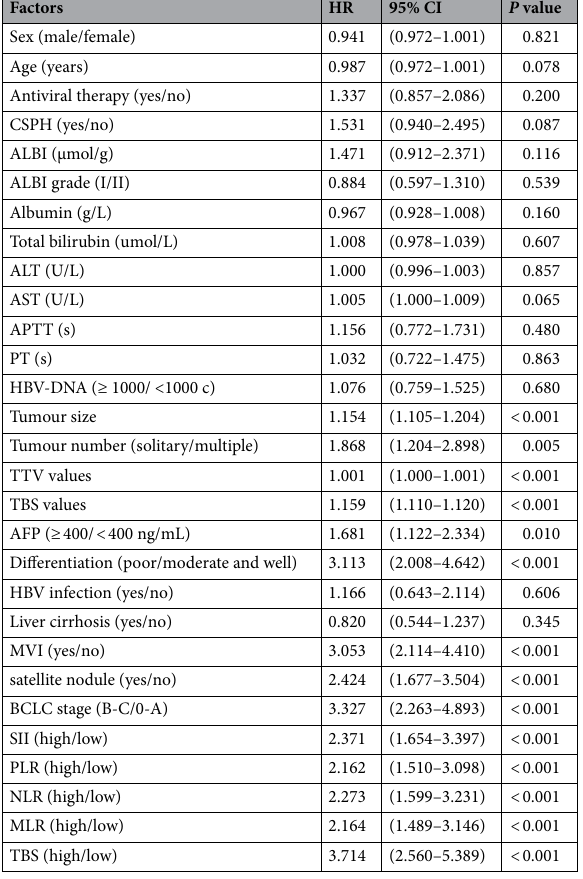
Table 3. Univariate analysis of RFS. ALT alanine transaminase, AST aspartate trasaminase, PT prothrombin time, APTT activated partial thromboplastin time, AFP alpha-fetoprotein, MVI microvascular invasion, BCLC hazard ratio, AIBL albumin-bilirubin grade, CSPH clinically significant portal hypertension.